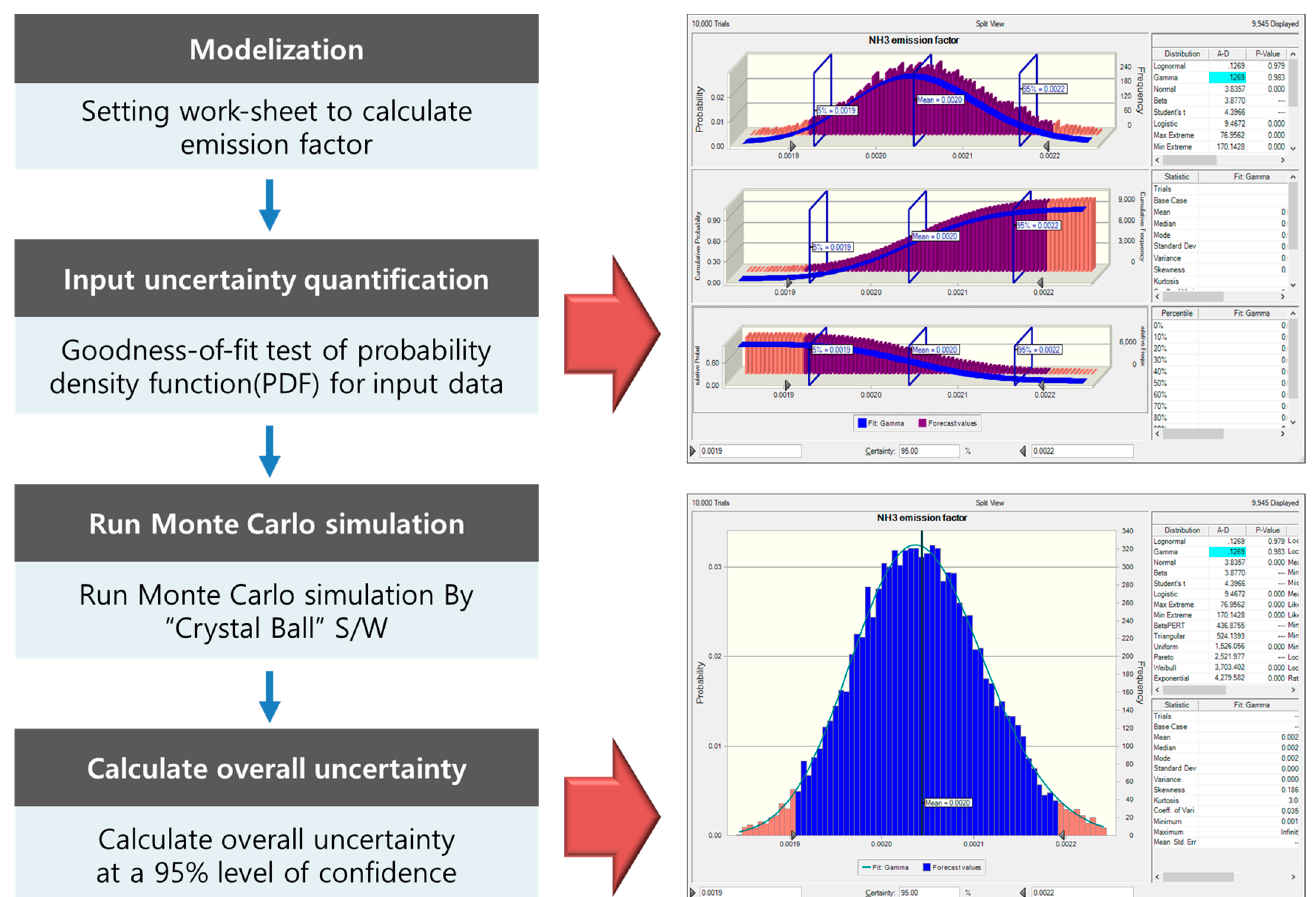
Figure 2. Process of the Monte Carlo simulation for estimating the uncertainty of the emission factor.